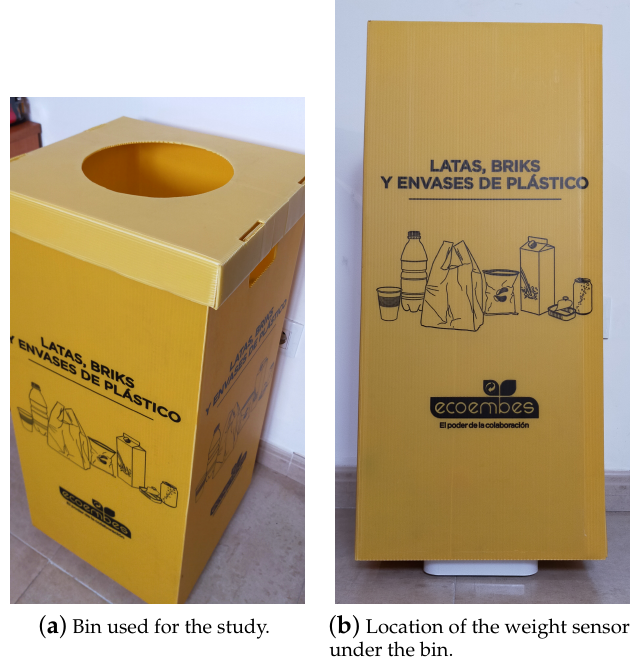
Figure 2. Household plastic-waste collection. The label in the bin reads “Cans, cartons and plastic packaging” in Spanish.